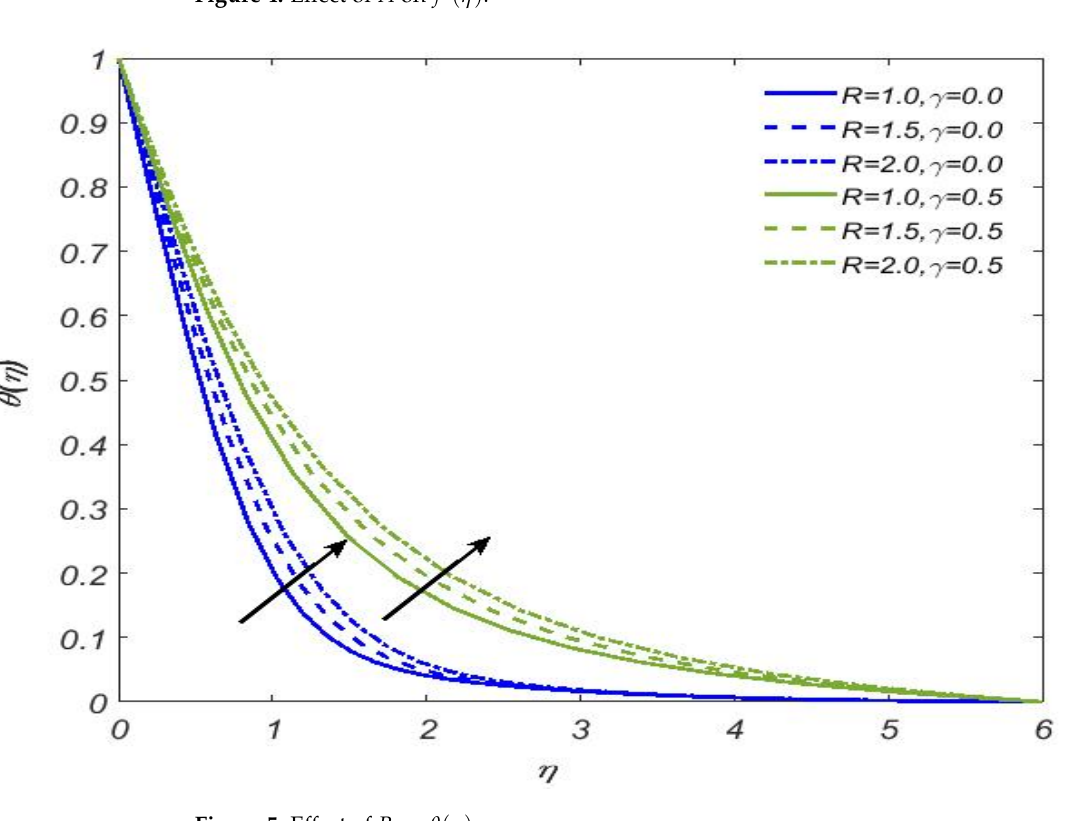
. Figure 4. Effect of A on f